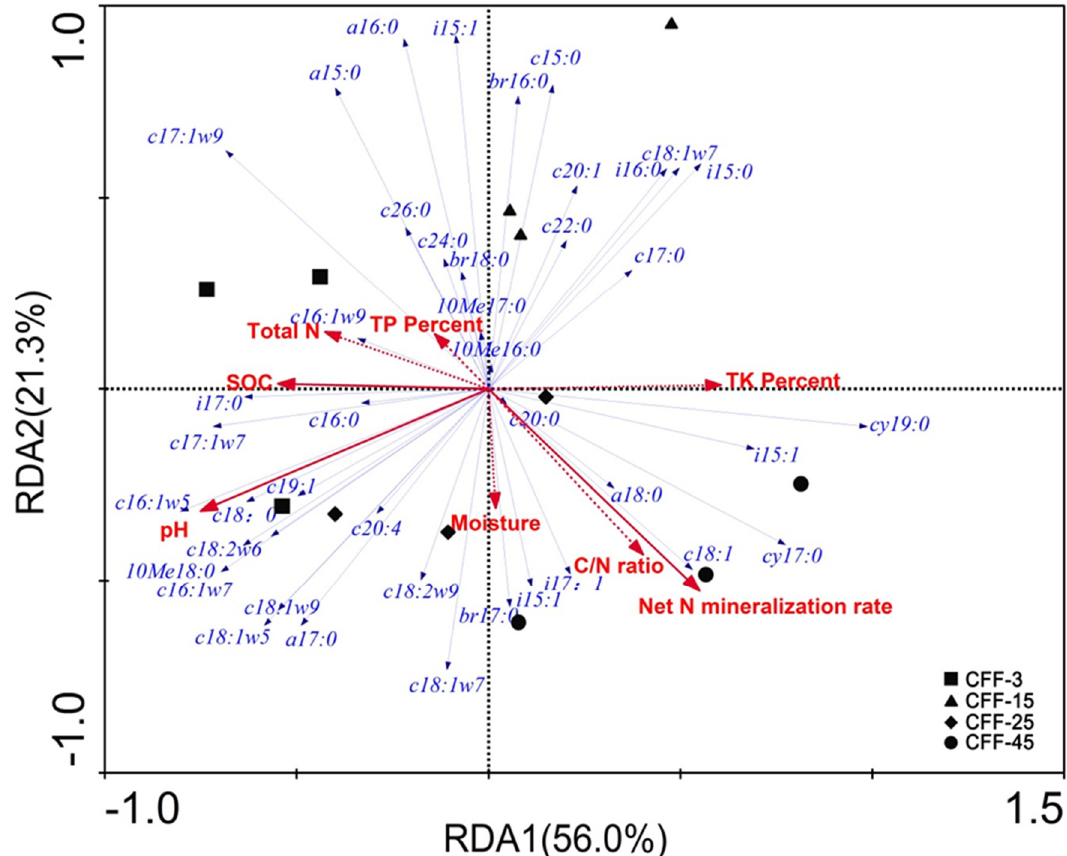
Figure 5. Redundancy analysis on the relative abundance of PLFA biomarkers and soil physicochemical properties in Jiangxi Province. Soil properties that were significantly correlated with factors were stressed (Monte Carlo permutation tests, P < 0.05). Vectors (indicating soil properties) of greater magnitude and forming smaller angles with an axis are more strongly correlated with that axis. CFF-3, 3-year Chinese fir forests; CFF-15, 15-year Chinese fir forests; CFF-25, 25-year Chinese fir forests; CFF-45, 45-year Chinese fir forests.